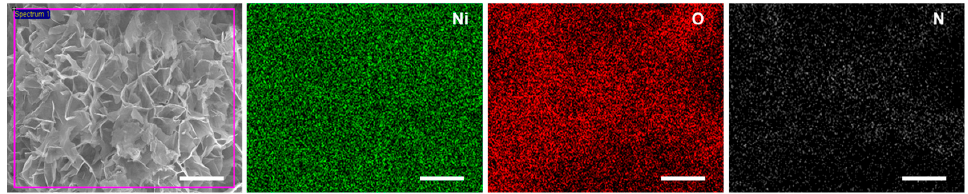
Figure 3. EDS mapping images of N-doped NiO NSs (scale bar = 4 μ m).